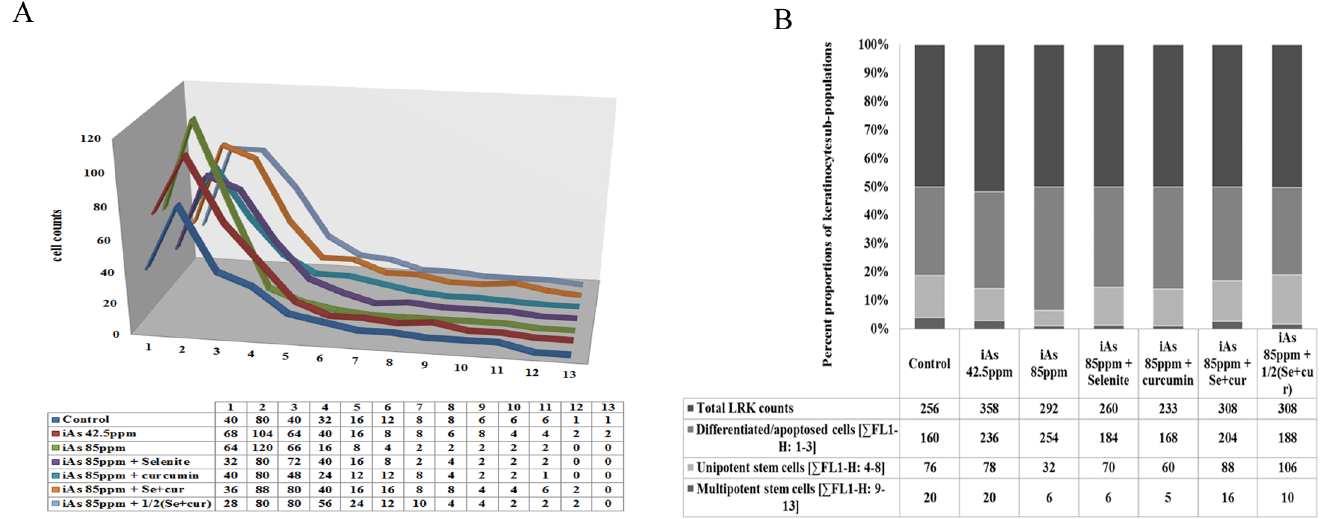
Fig 2. EpASCs, TA, and differentiated cell count profile in LRK pool from neonate epidermis after in utero exposures to iAs and the additives. (A) the change in cell counts per 1/10 th change in FL1-H value were plotted; numerical values represent maximum cell counts per 1/10 th of change in label density shown in Fig 1A – 1G; (B) the cell counts showing approximately similar degree of change [ ∑ FL1-H 1 – 3, ∑ FL1-H 4 – 8, ∑ FL1-H 9 – 13] showcased three sub-populations of cells [16, 57] namely keratinocytes retaining (i) greatest quantity of BrdU label i.e. adult stem cells (EpASCs), (ii) least amount of BrdUlabel i.e. differentiated or apoptosed cells, and (iii) intermediate amount of BrdU label i.e. the progenitor TA cells on the way to differentiation.